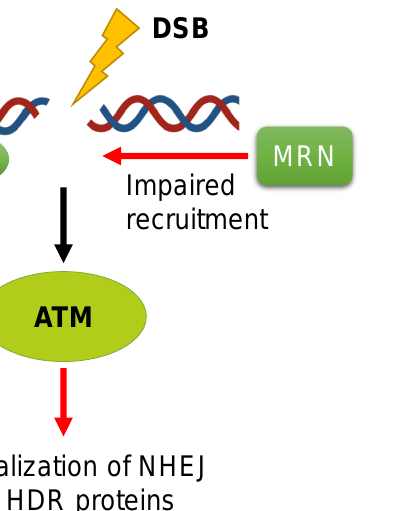
Figure 4. Aberrant DNA damage response (DDR) and telomere positioning in progerin-positive cells. ( A ): Initial and downstream DDR signaling perturbed in HGPS cells. ( B ): Decreased mobility of telomeres identified, with more than half in proximity of the nuclear lamina. DDR and p53 activation is up-regulated at telomeres. p53 is responsible for much of the senescent phenotype of HGPS cells, and its activation is abrogated by the expression of